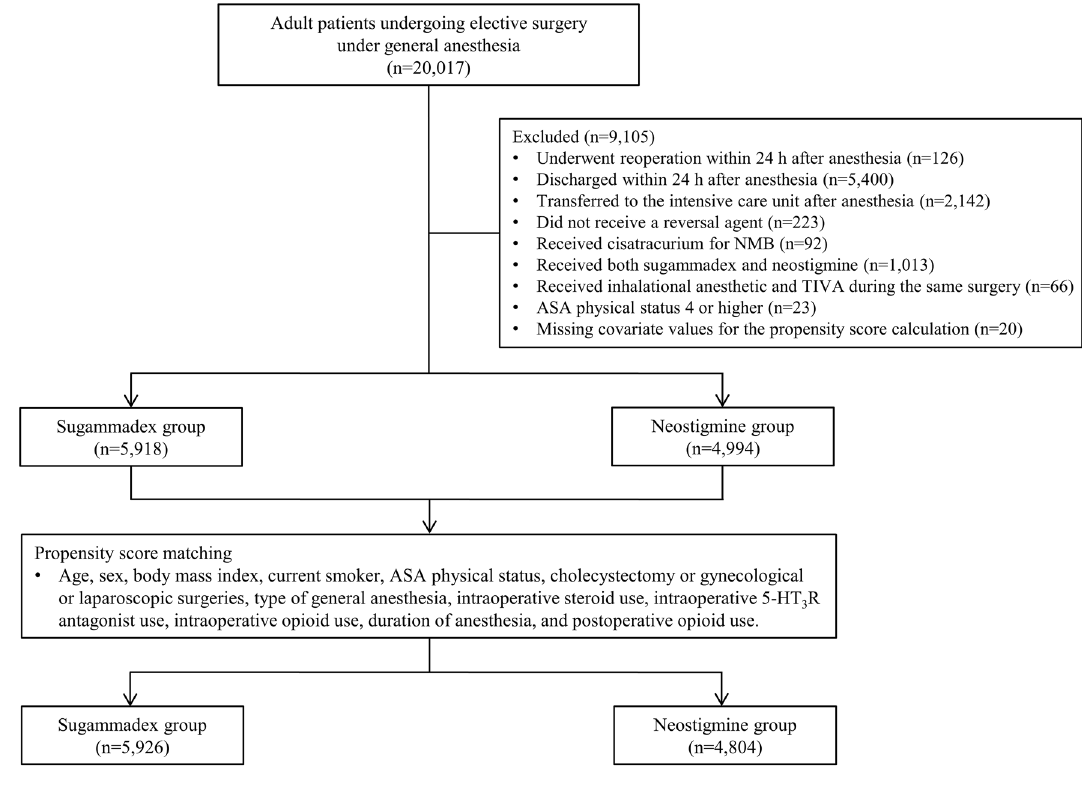
Figure 1. Flow diagram of the study. ASA, American Society of Anesthesiologists; NMB, neuromuscular blockade; TIVA, total intravenous anesthesia; 5-HT 3 R, 5-hydroxytryptamine